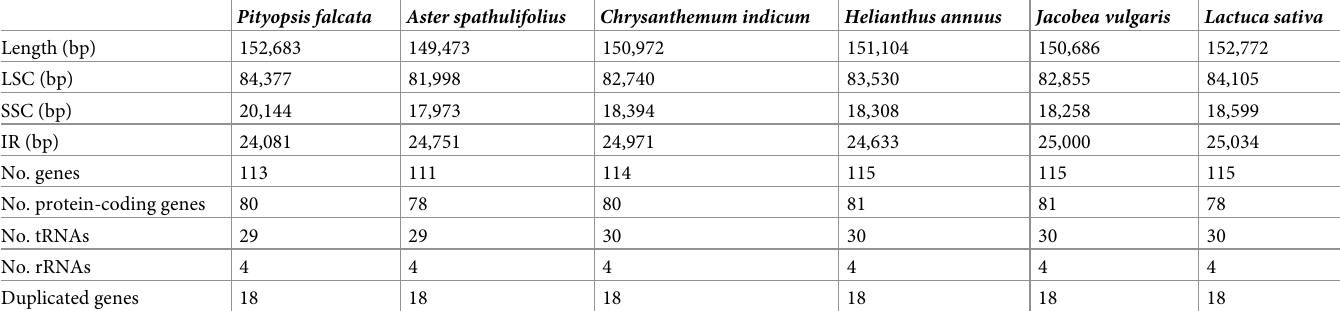
Table 2. Comparison of the Pityopsis falcata chloroplast genome to other Asteraceae species.